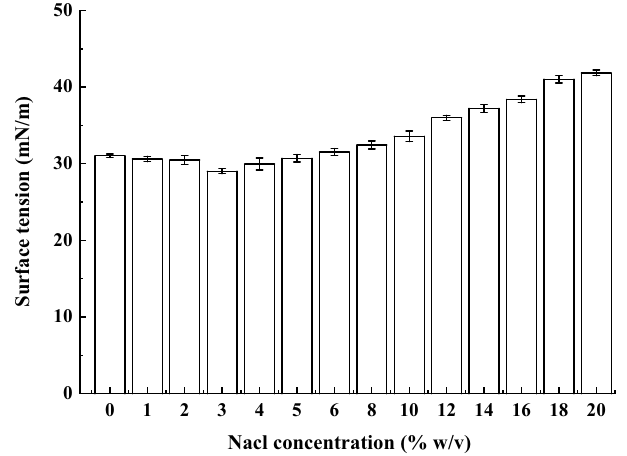
Figure 8. Effect of NaCl concentration on biosurfactatnt stability produced by B. subtilis SL.